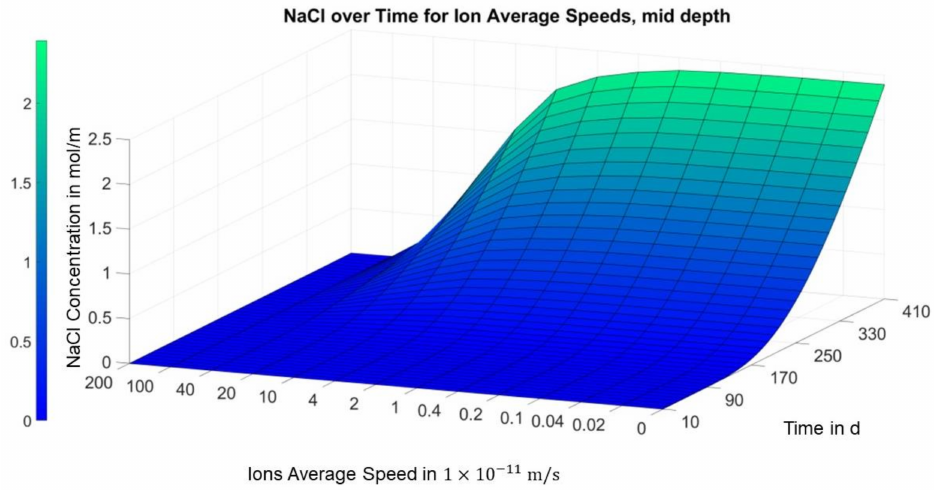
Figure 10. Finite differences solution for concentration over migration speed and time.